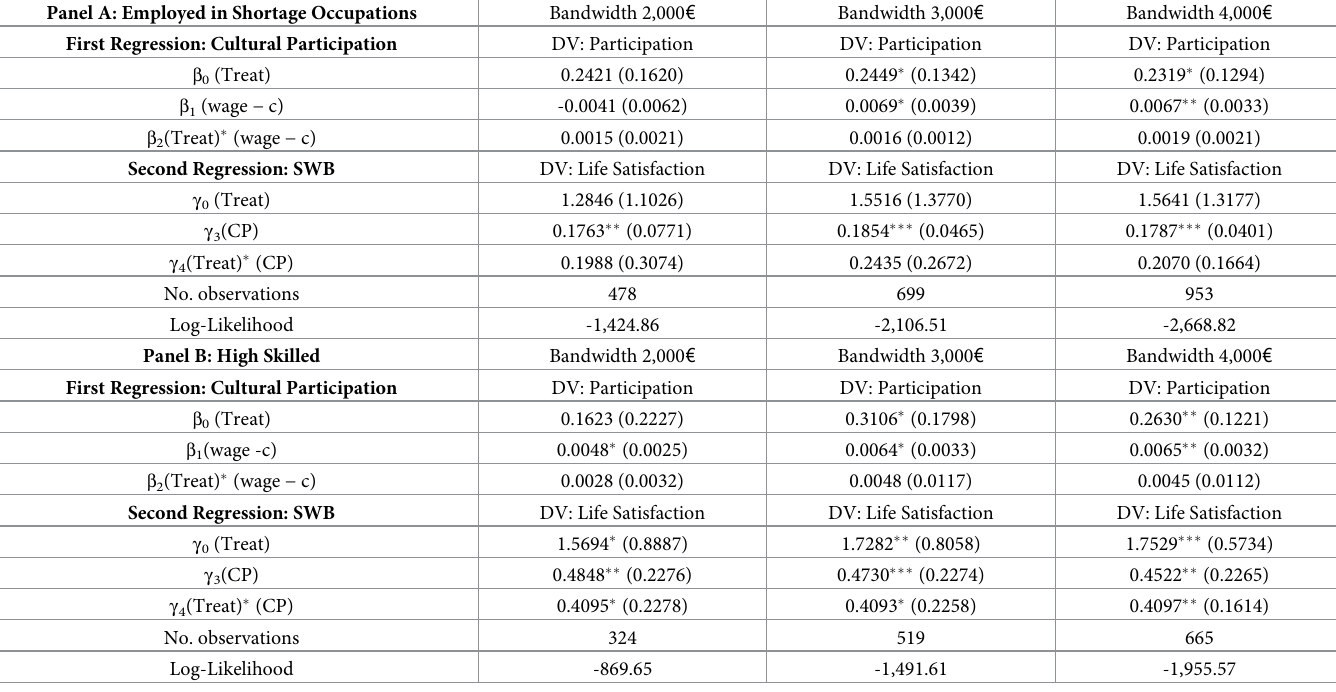
Table 5. RDD seemingly unrelated regression estimates using Ordered Probit and uniform Kernel for participation in classical music performance, opera or theatre. Panel A: Employed in Shortage